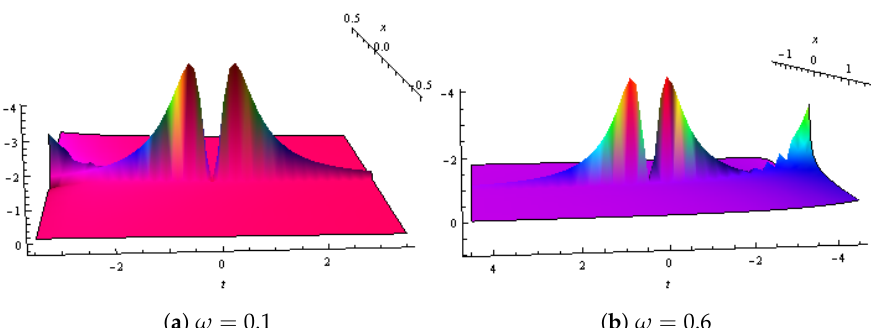
Figure 12. ( a , b ) show 3D plots.